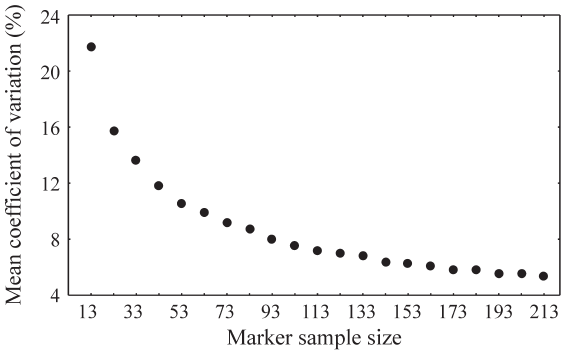
Figure 1 - Mean coefficients of variation of the genetic distances between lines, estimated by the bootstrap procedure for different marker sample sizes.